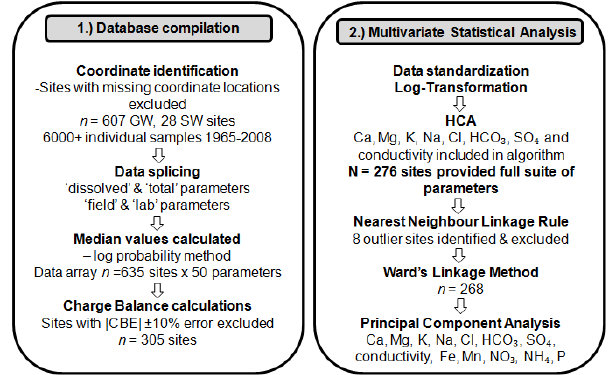
Fig. 3. Schematic representation of the methodologies used for Figure 3. Schematic representation of the methodologies used for compiling and analyzing the 3 compiling and analyzing the hydrochemical database. “SW” de- hydrochemical database. ‘SW’ denotes surface water monitoring sites, ‘GW’ denotes 4 notes surface water monitoring sites, “GW” denotes groundwater groundwater monitoring sites and ‘n’ denotes sample size. 5 monitoring sites and “ n ” denotes sample